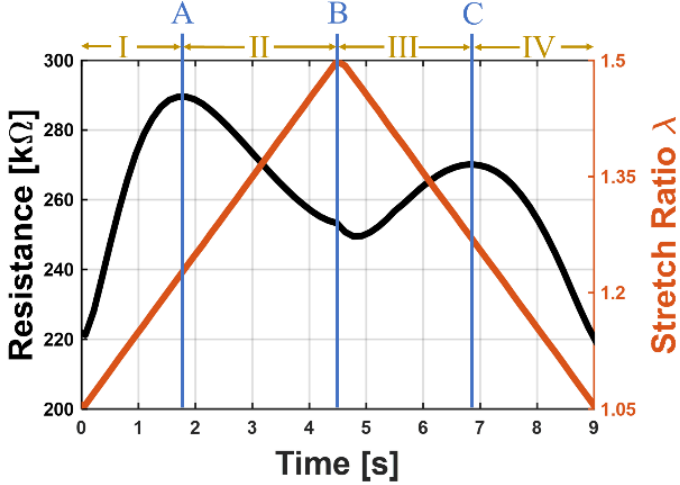
Figure 8. Distinguished regions and important points for the observed phenomenon based on an exemplary resistance-time behavior while one load-unload cycle: Region I: Increasing resistance with increasing elongation; Point A: First maximum of the resistance; Region II: Decreasing resistance while stretch ratio is still increasing; Point B: Maximal stretch ratio; Region III: The sample becomes unloaded, thus, the stretch ratio decreases and the electrical resistance increases; Point C: Second maximum of the resistance; Region IV: The electrical resistance decreases to its initial value when the sample is completely relaxed.